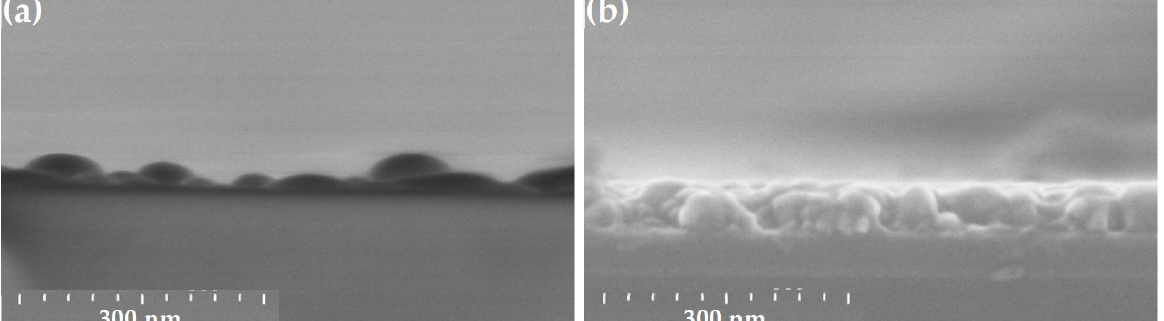
Figure 7. Cross-sectional SEM views of sol-gel spin-coated ZnO samples obtained with MEA contents r = 0 ( a ) and 1.0 ( b ).